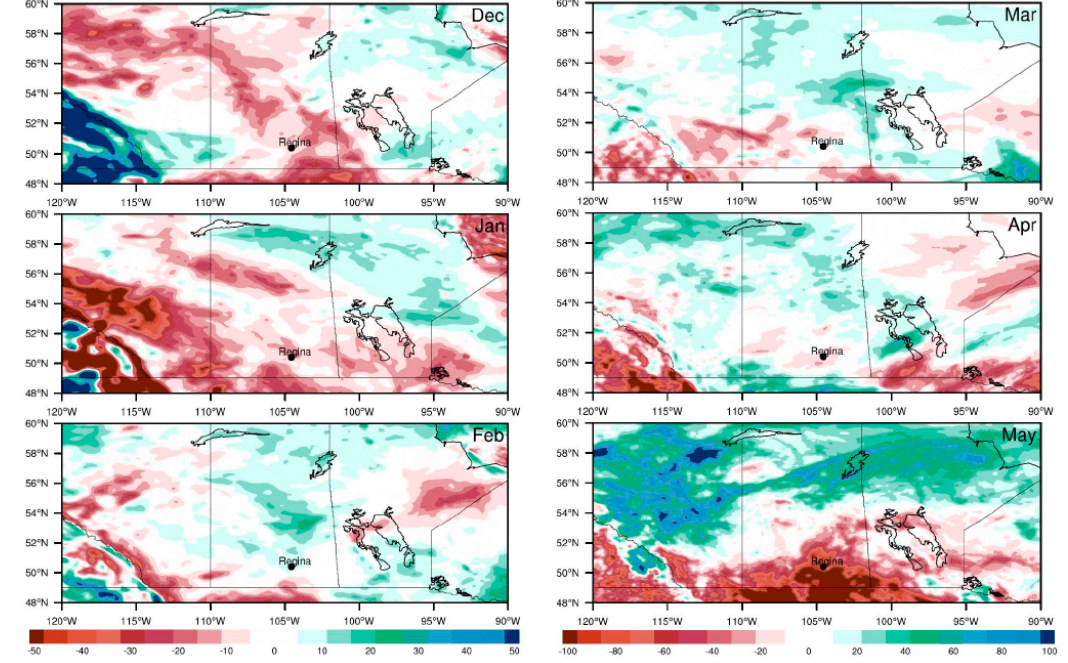
Figure 5. The di ff erence (ELX-LAX) in WRF simulated total precipitation (mm) for winter and